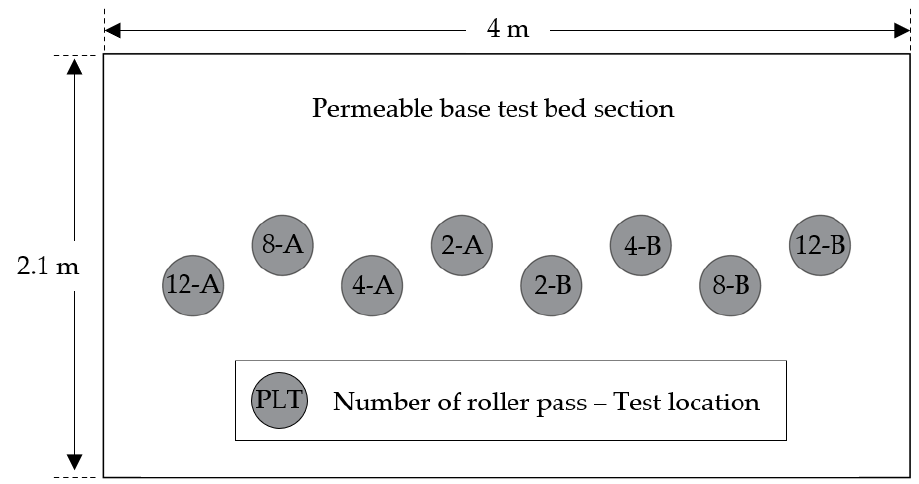
Figure 6. Layout of test locations for PLT [38].